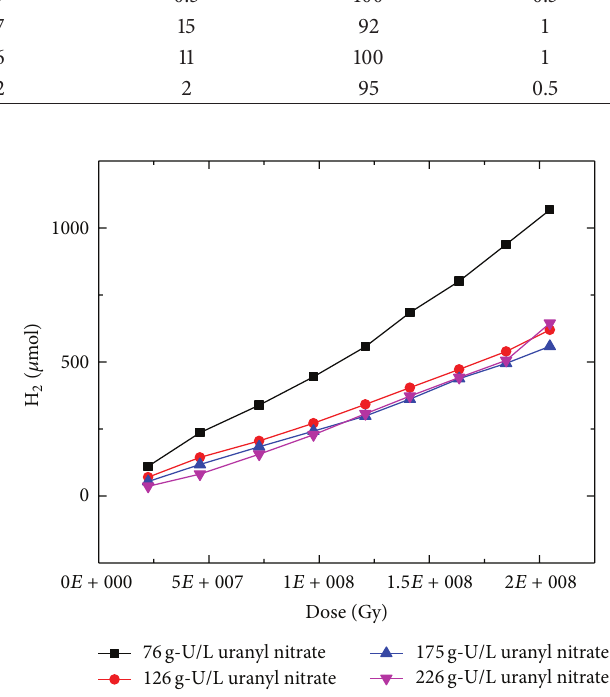
Figure 2: Hydrogen evolution measured during irradiation of UO 2 (NO 3 ) 2 solutions at the Van de